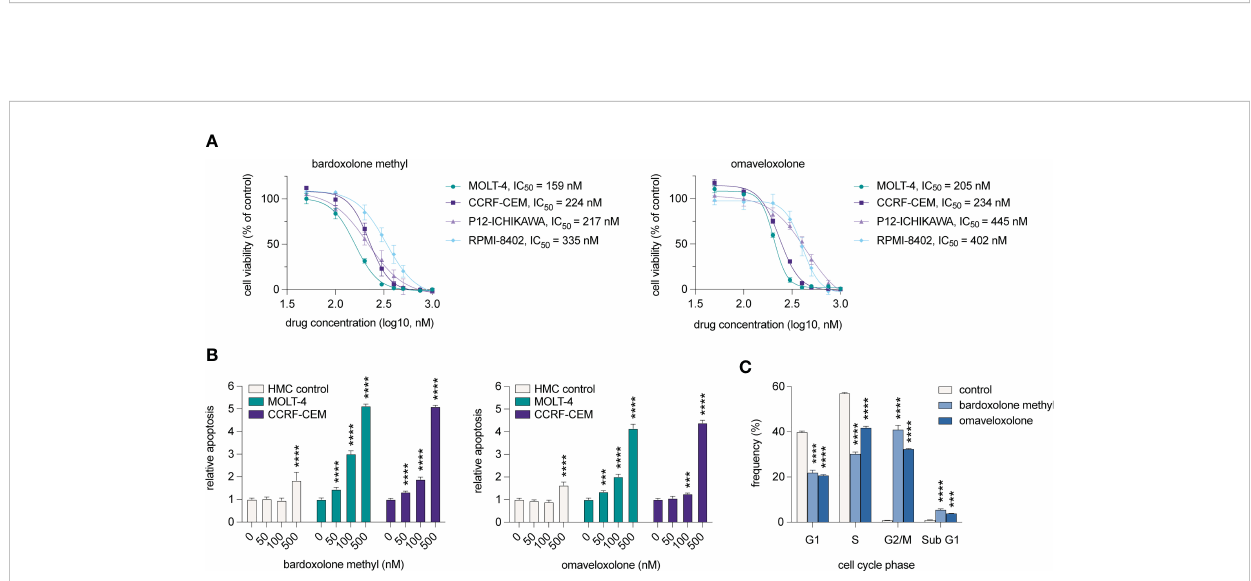
FIGURE 5 OT treatment leads to G2/M arrest, decreased cell viability, and induction of apoptosis in T-ALL cells. (A) Cell viability of T-ALL cells treated with OTs for 72 h. Data points represent the average of three independent experiments. Error bars indicate standard error of the mean. IC 50 is de fi ned as the drug concentration reducing cell viability by 50%. (B) Apoptosis as measured by caspase 3/7 activity after 48 h of treatment with OTs. (C) Cell cycle distribution of MOLT-4 cells after 24 h treatment with 250 nM OTs. Error bars indicate standard error of the mean. One-way ANOVA test (*** P < 0.001; **** P < 0.0001). Data shown represents one of three independent experiments. HMC, human mononuclear cells isolated from a healthy